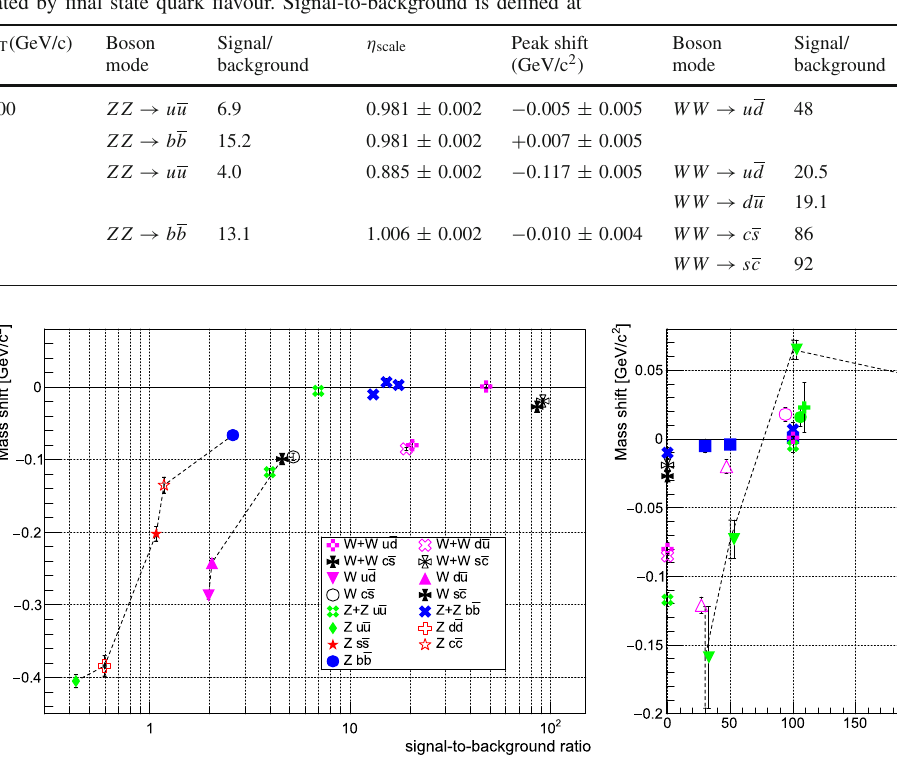
Fig. 13 Summary of the observed shifts in peak positions. Left shows the peak shift as a function of the signal-to-background ratio in the final state, with inclusive production and recoil against a W or Z . For both the W and Z produced singly, a dashed line links the different decay